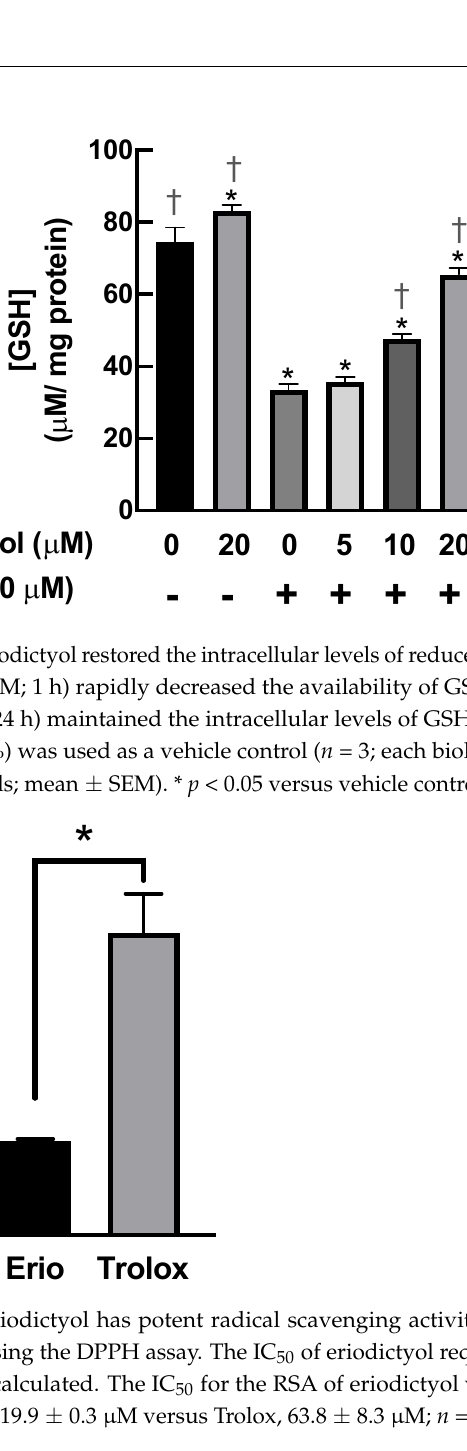
Figure 5. Eriodictyol has potent radical scavenging activity (RSA). The RSA of compounds was eval- uated using the DPPH assay. The IC 50 of eriodictyol required to decrease the radical activity of